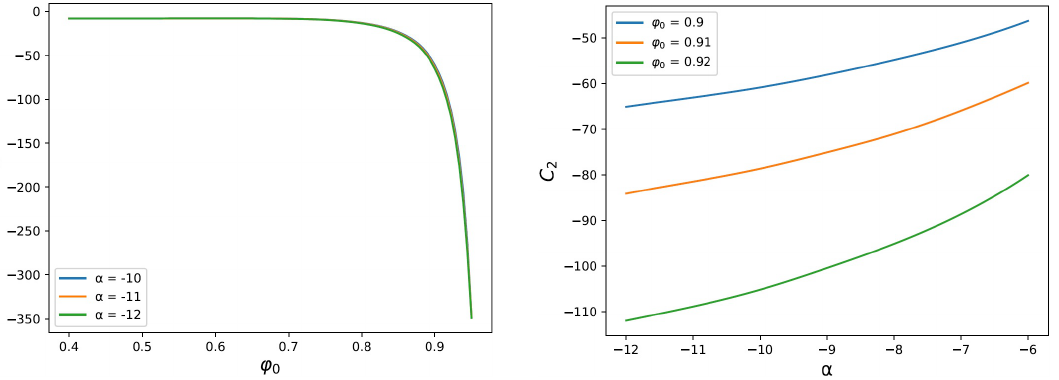
Figure 21 . Left: the integration constant C 2 as a function of ϕ 0 for fixed values of α , for Bolt end-point solutions. Right: the integration constant C Bolt end-point